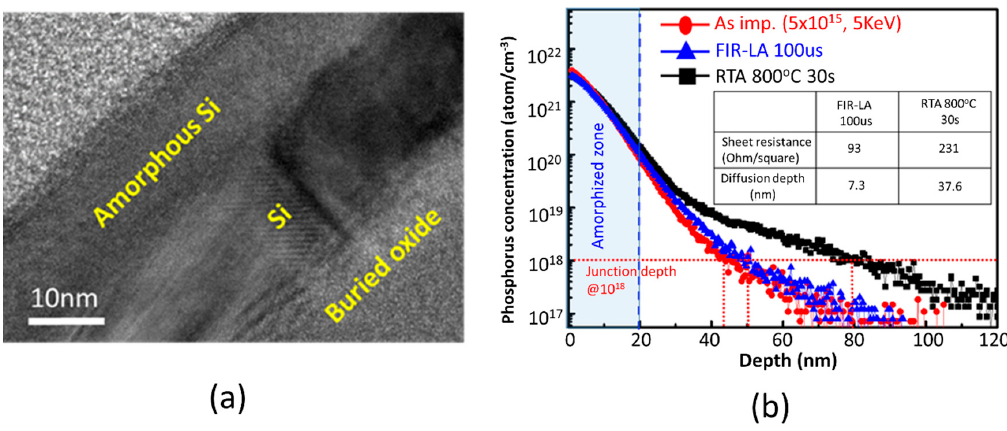
Figure 5. ( a ) A HRTEM image of Si after dopant implantation. ( b ) Dopant profiles characterized by a secondary ion mass spectrometer (SIMS). The inset table presents the sheet resistance